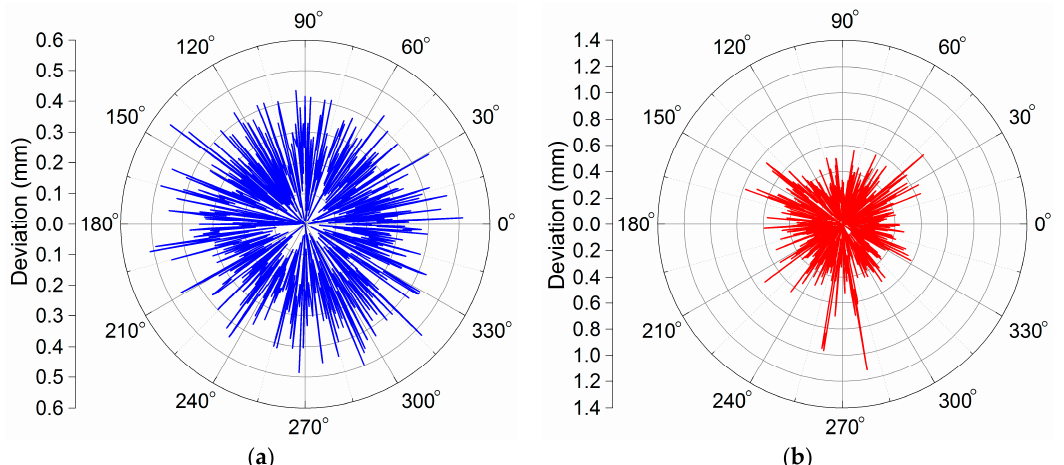
Figure 36. Deviation results of target planning path and actual tool path of experimental deburring for distal side facet (polar representation): ( a ) facet edges deburring deviation; ( b ) orifice edges deburring deviation.